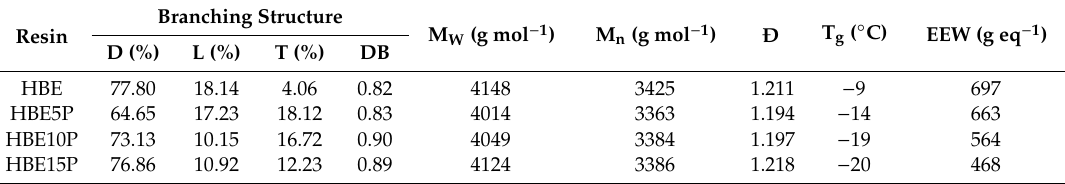
Table 2. Dendritic (D), linear (L), and terminal (T) units (%), degree of branching (DB), and